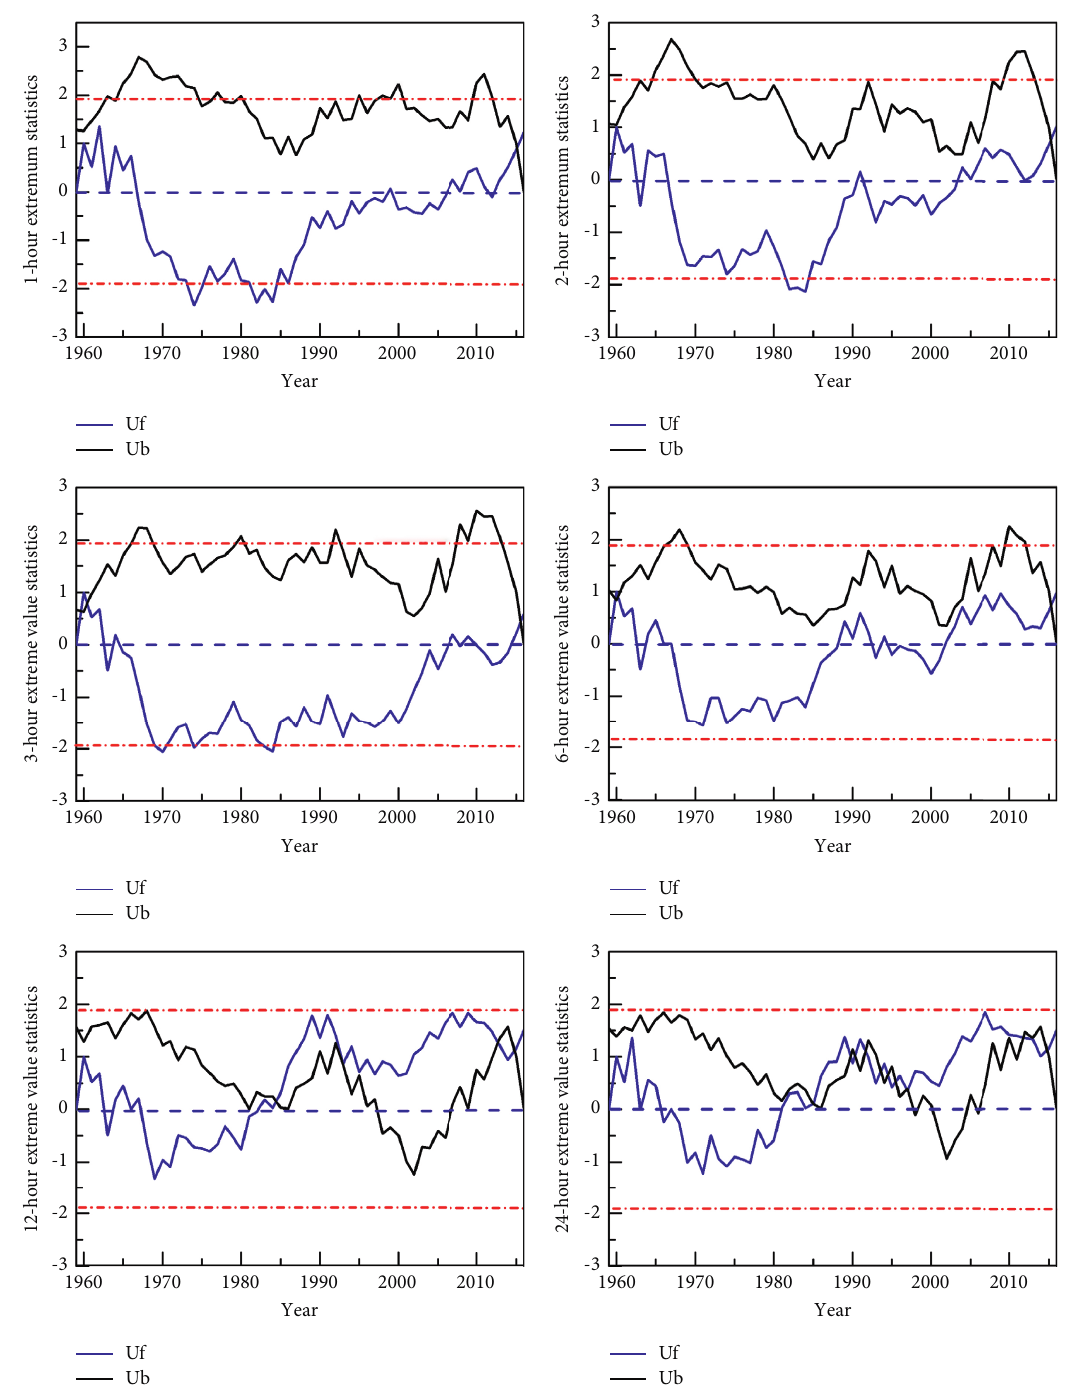
Figure 11: Abrupt changes in intensities of precipitation with different durations in the study area from 1959 to